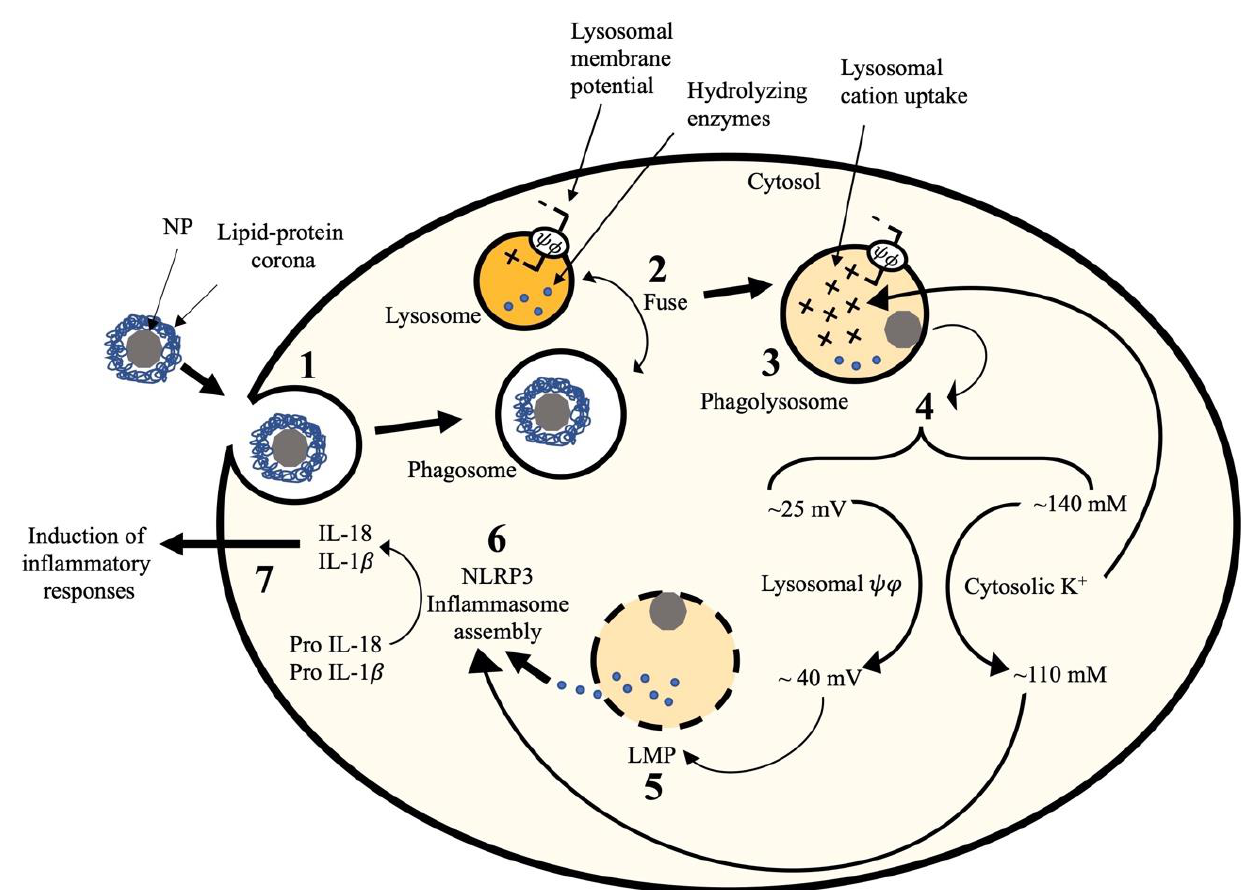
Figure 8. NP-induced lysosomal hyperpolarization triggers LMP. (1) NP covered with lipid-protein corona are internalized into macrophage, creating phagosome. (2) Phagosome ifuses with lysosome creating phagolysosome containing hydrolyzing enzymes in an acidic pH. (3) NP interactn with phagolysosomal membrane. (4) This interaction causes two simultaneous changes in macrophage: (A) decreasing the cytosolic K + and (B) increasing lysosomal membrane permeability to cation, which is likely K + translocating from cytosol to lysosome, leading to lysosomal membrane hyperpolarization. (5) Lysosomal hyperpolarization osmotically disturbs lysosomal integrity, which eventually leads to LMP. (6) The release of lysosomal hydrolyzing enzymes as a result of LMP induces NLRP3 inflammasome activation, including the release of proinflammatory cytokines such as IL-1 β . (7) Release of proinflammatory cytokines induces the inflammatory responses.